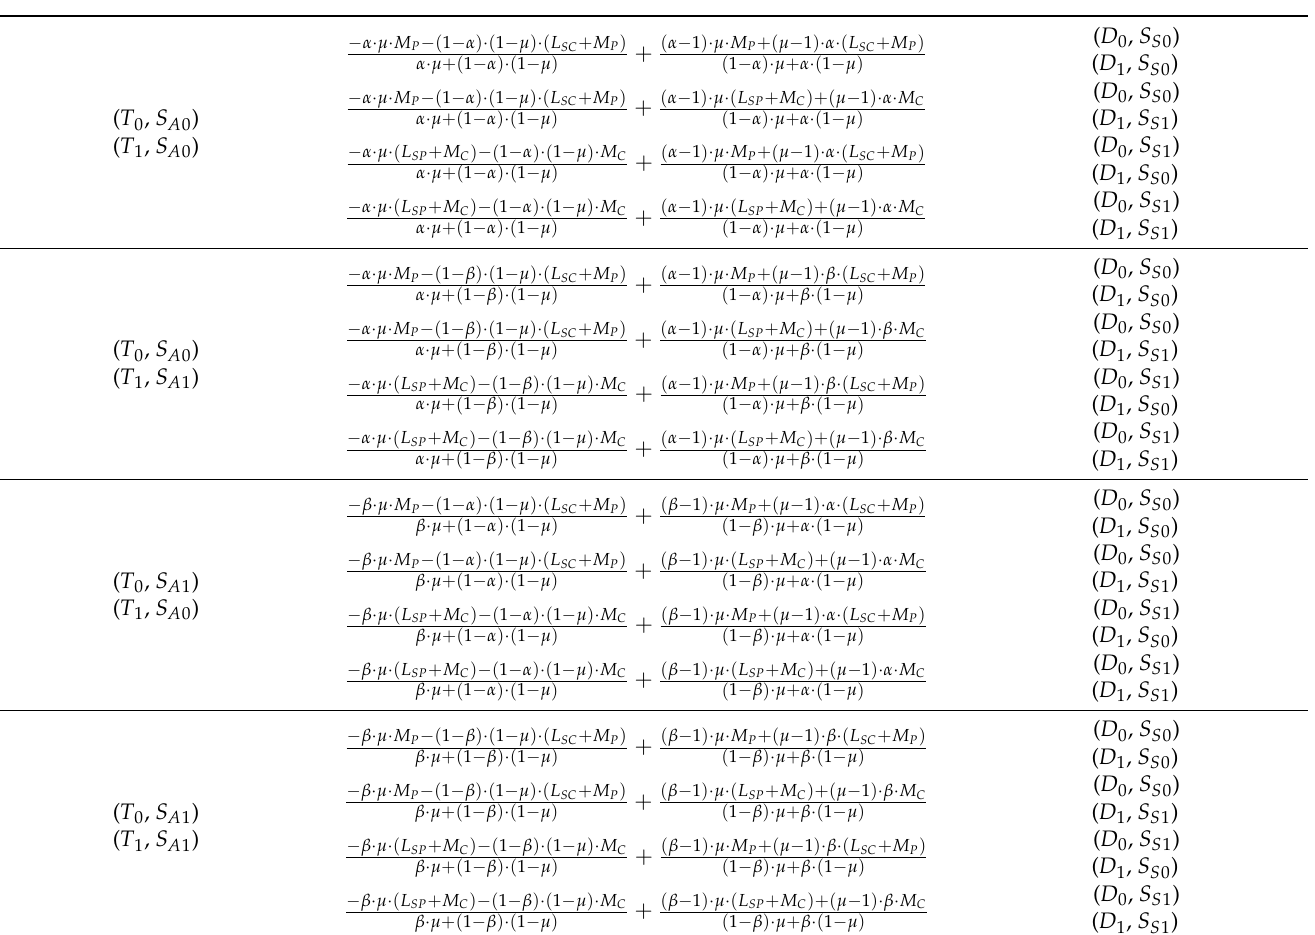
Table 3. Income Function of the